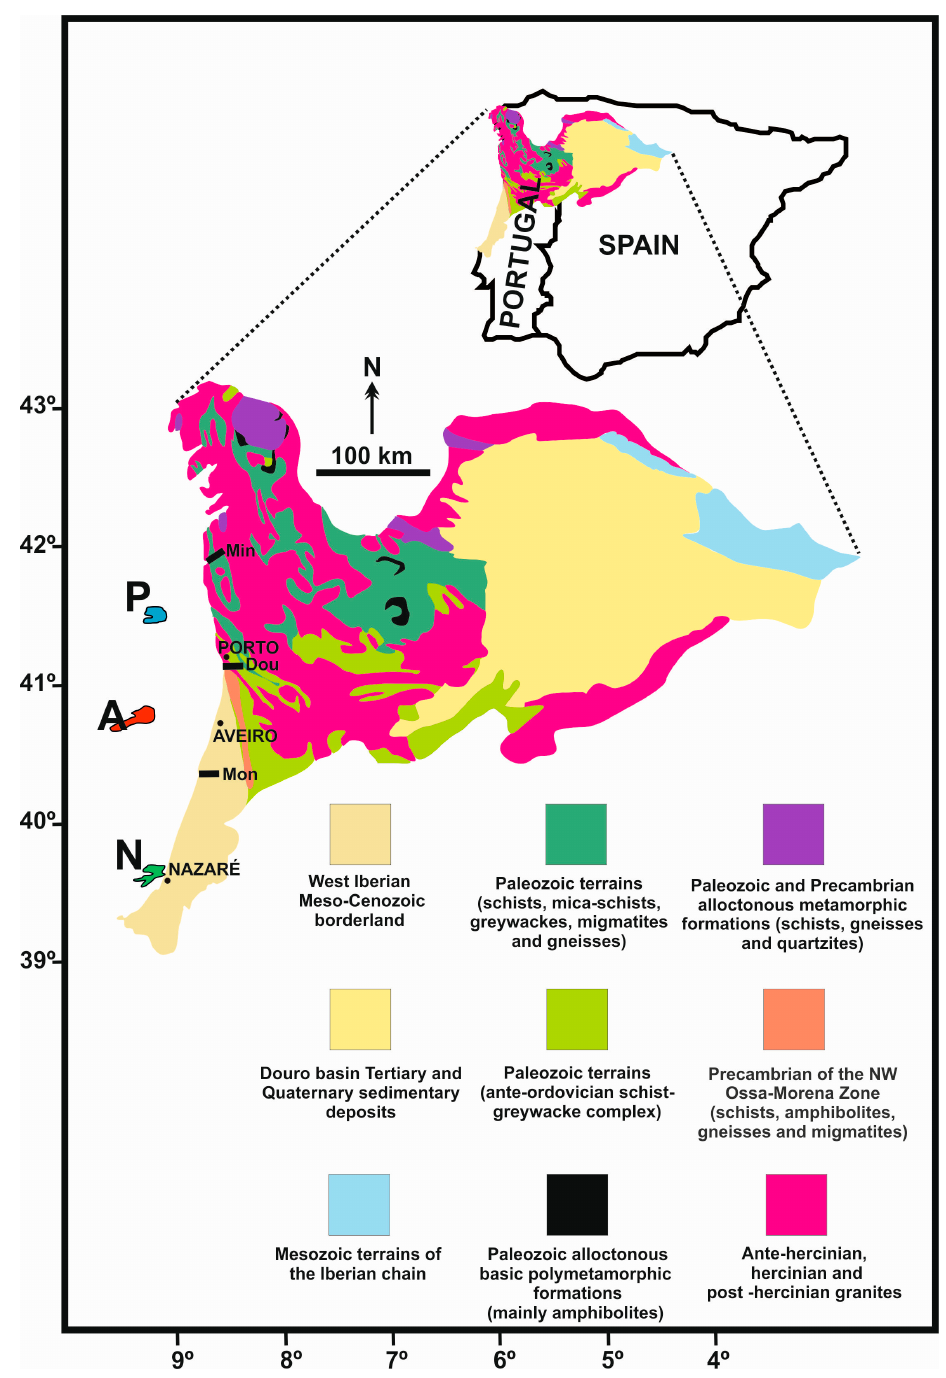
Figure 2. Simplified geological map considering the areas of the main northern Iberian Peninsula and Portuguese river basins: Minho (Min), Douro (Dou) and Mondego (Mon). P, A, and N represent the location of the sea bottom areas with samples collected respectively from Porto, Aveiro, and Nazaré upper canyon areas (adapted from [21]).